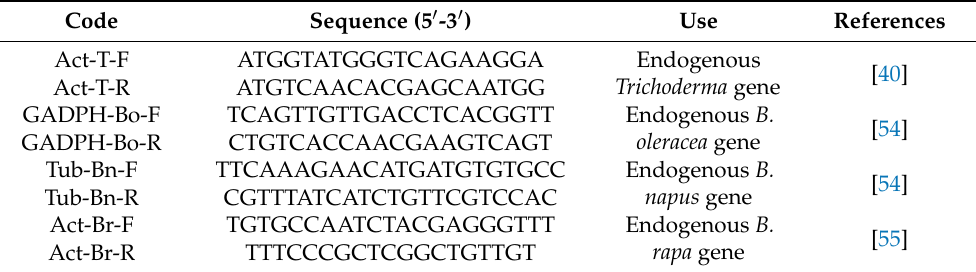
Table 1. Primers used in the quantification of Trichoderma -root